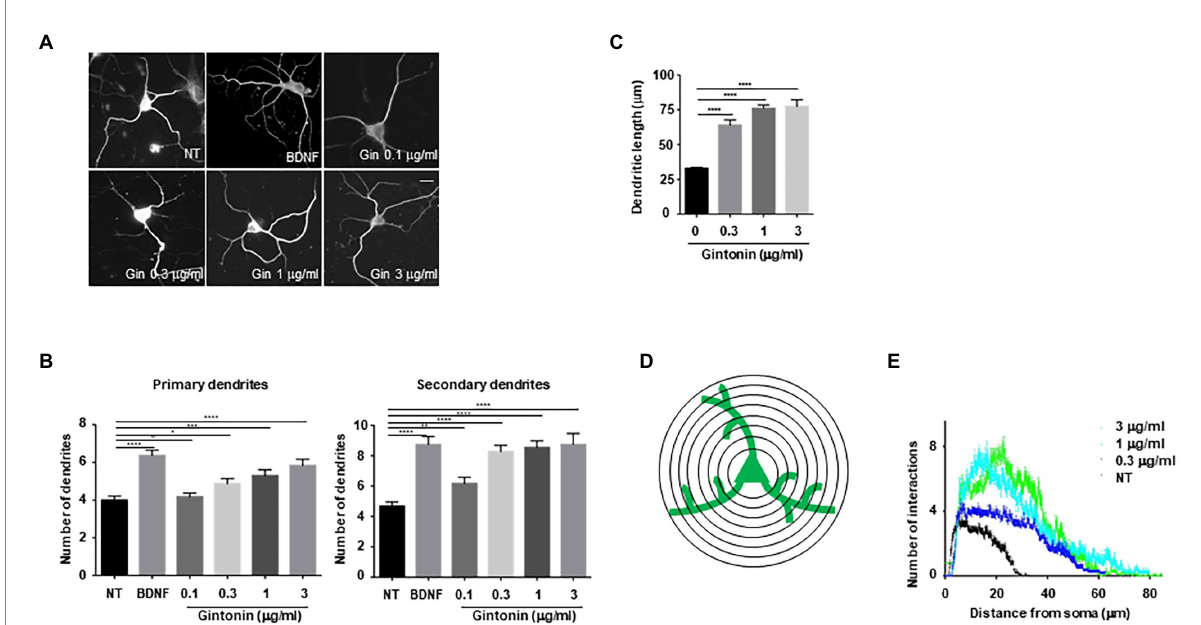
FIGURE 2 Gintonin induces dendritic growth in striatal neurons. Cultured striatal neurons were treated with the indicated dose of gintonin at DIV2. After 5 d of exposure, the cultures were fixed and stained with anti-microtubule-associated protein 2 (MAP2) antibody. Neuronal processes were counted with fluorescence microscopy. BDNF (40 ng/ml) was used as a positive control for striatal dendritic growth. (A) Representative images of gintonin and BDNF-treated striatal neurons. (B) Quantitation of the number of primary and secondary dendrites in gintonin-treated striatal neurons. (C) The total length of dendrites for gintonin and BDNF-treated neurons. (D, E) Sholl analysis of the dendritic arbor from gintonin-treated striatal neurons. Results are presented as means ± SEM from three independent experiments determined from the analysis of 40 neurons per condition per